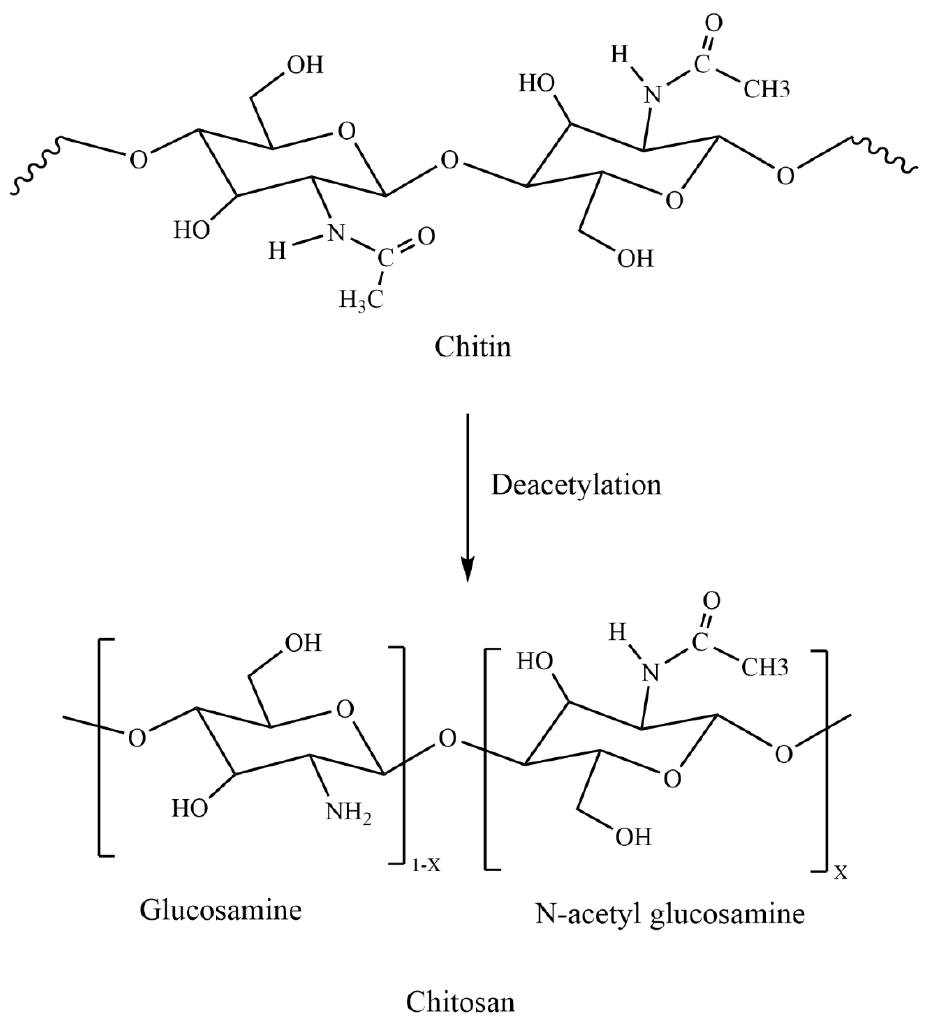
Figure 1. Schematic representation of chitosan.